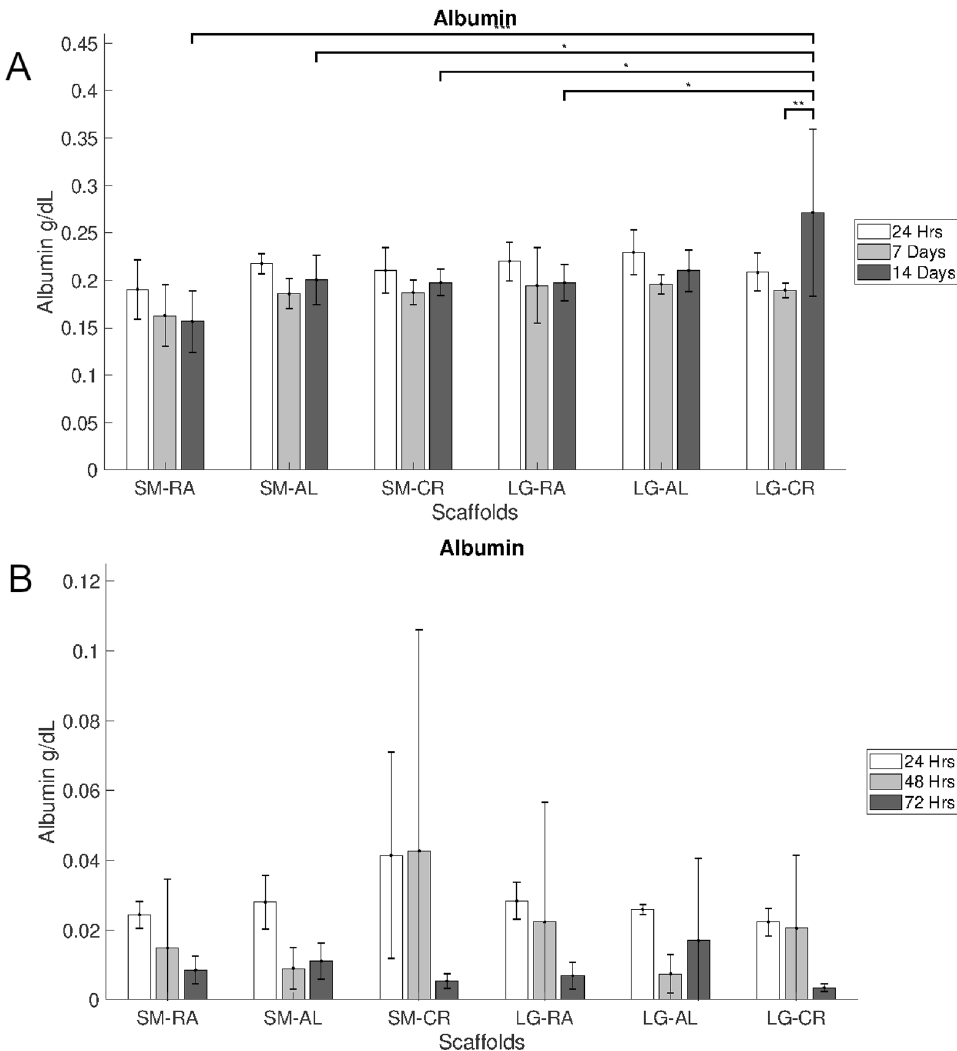
Figure 5. Bromocresol green 24 h albumin secretion measurements for ( A ) hepg2 over 14 days (N = 5) and ( B ) MPHs over 3 days (N = 3). Error bars = SD and *p < 0.05, **p < 0.01 and ***p <